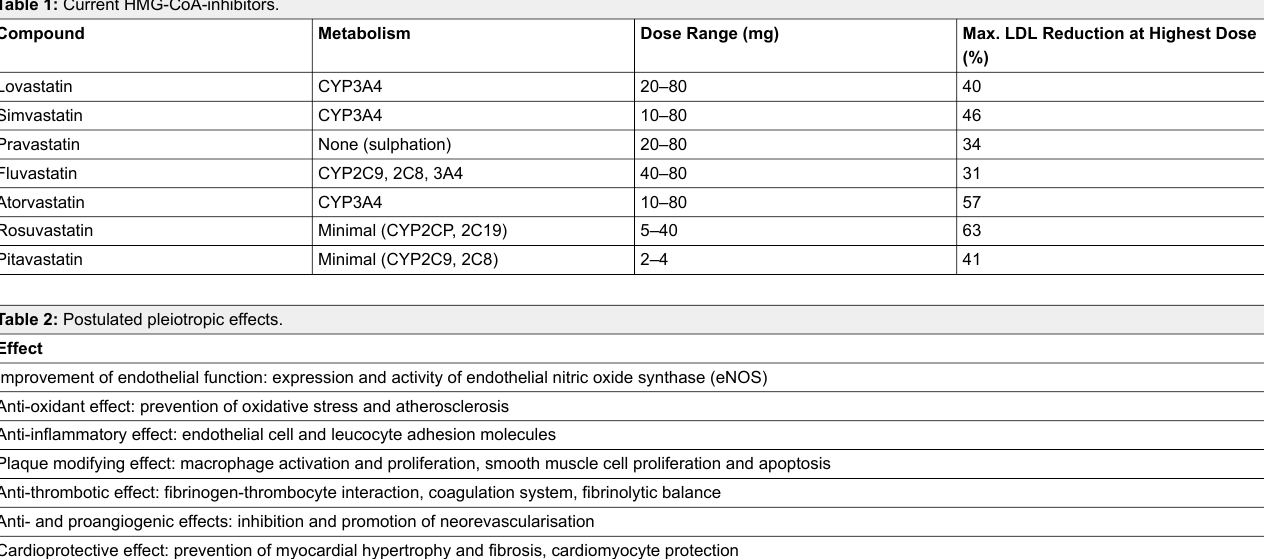
Table 1: Current HMG-CoA-inhibitors.